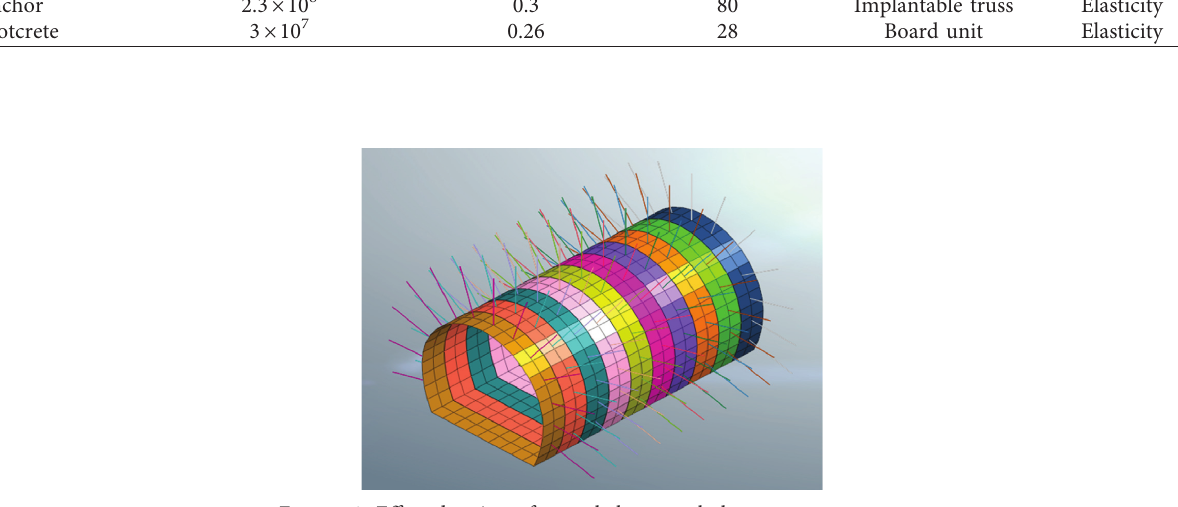
Figure 9: Effect drawing of tunnel shotcrete-bolt support structure.